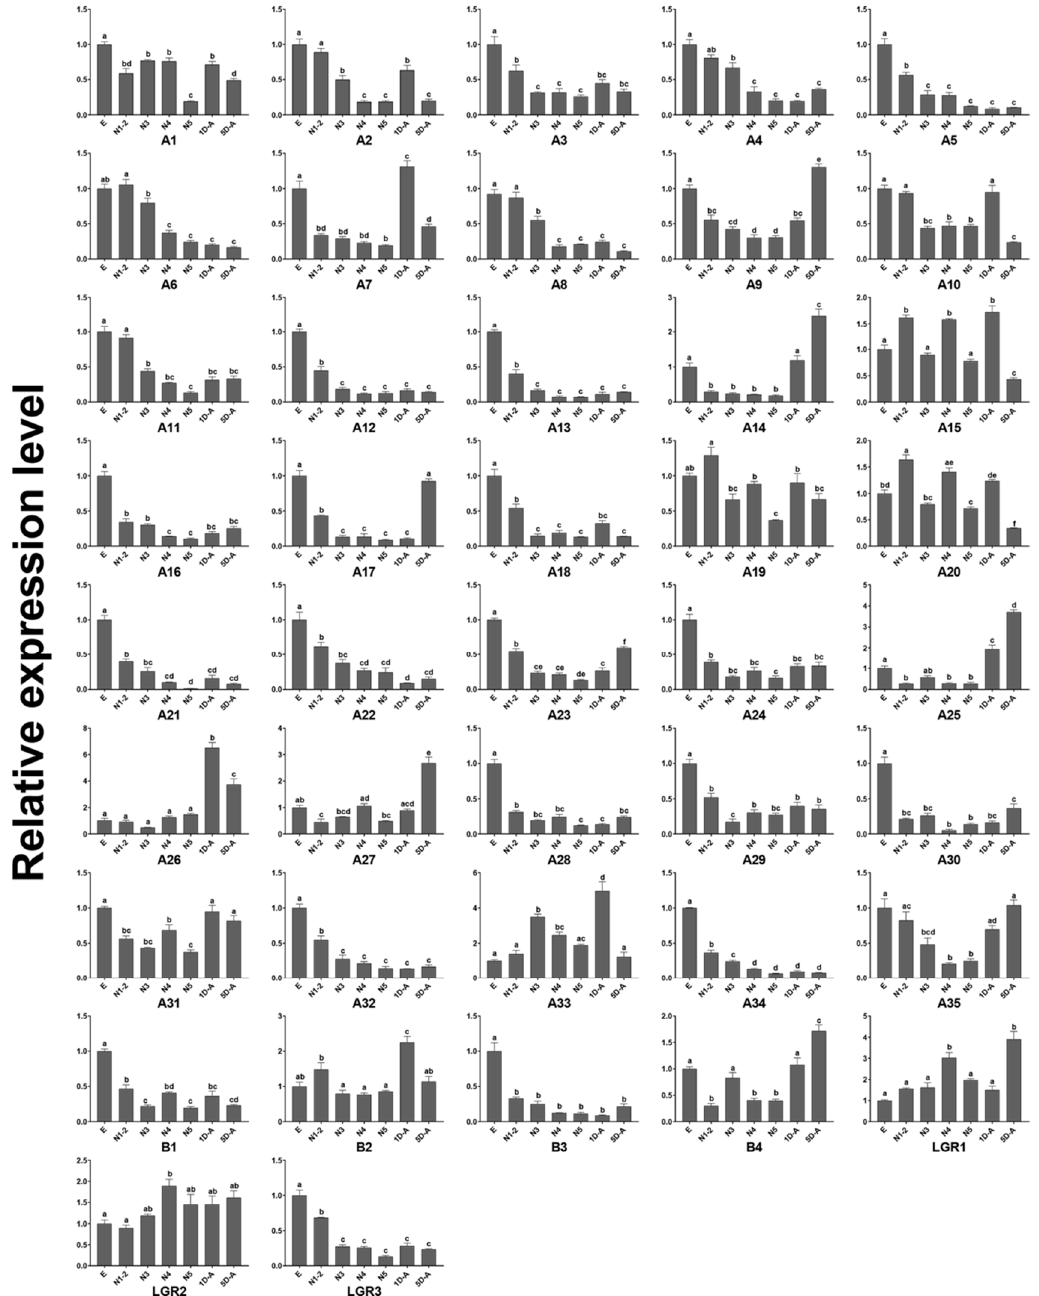
Figure 8. The gene expression level of neuropeptide receptors throughout the D. citri life cycle. The y -axis represents the relative expression level and the x -axis the life cycle. The standard error is represented by the error bar and significant differences are represented by the different letters ( p < 0.05). E, egg; N1-2, 1st- and 2nd-instar nymphs; N3, 3rd instar nymphs; N4, 4th instar nymphs; N5, 5th instar nymphs; 1D-A, the adults of one day after eclosion; 5D-A, five days after eclosion.